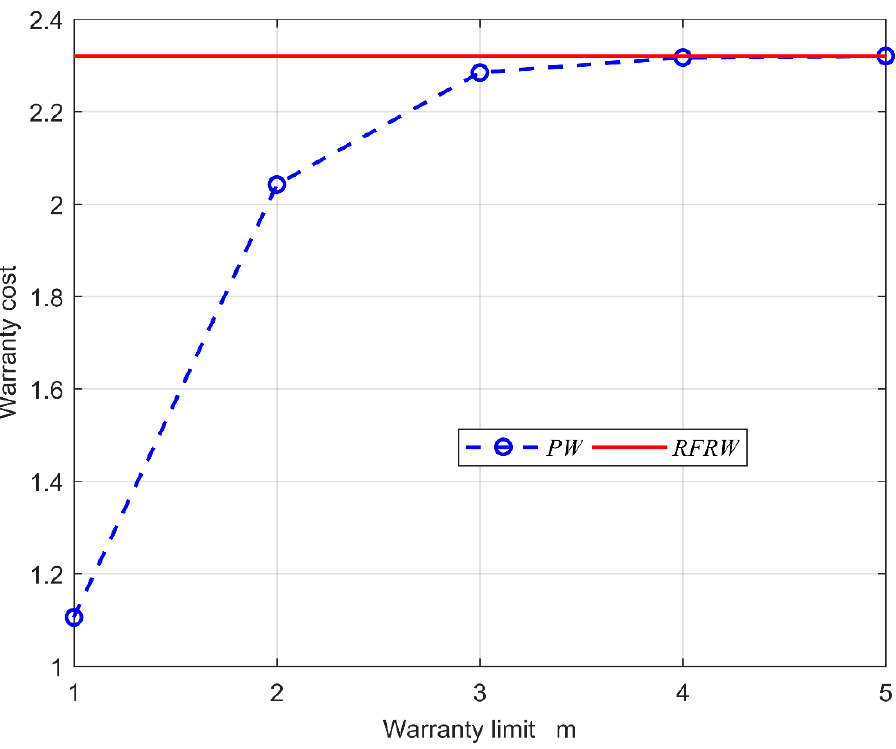
Figure 1. Warranty cost versus m .